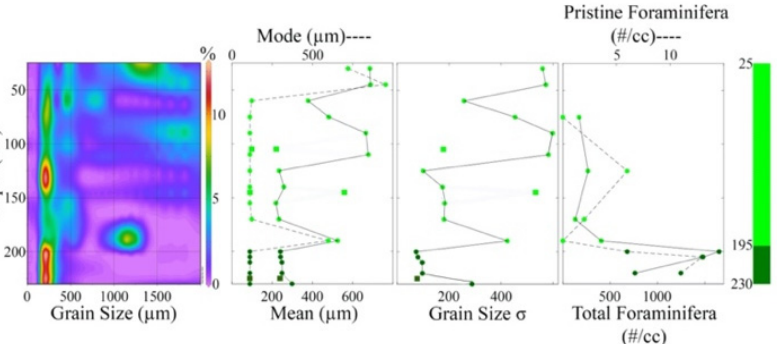
Figure 5. ‘LL Southern Baulk’ Results. ODV graph (far left ) showing grain size distribution and grain sorting with depth in the LL Southern Baulk Section (19 samples); grain size statistics; total and pristine foraminiferal abundances with depth for several samples taken from each unit; section illustration with the thicknesses of each unit. Light green data points correspond to the upper ‘LL Southern Baulk’ section samples, while the dark green points correspond to the lower ‘LL Southern Baulk’ section samples. .